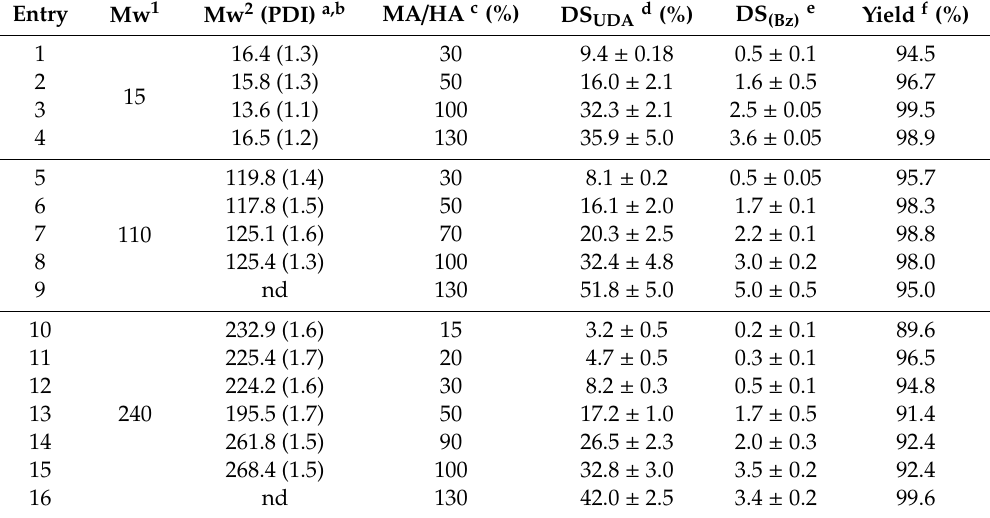
Table 1. Optimization of the esterification reaction for the preparation of Undecenoyl-Hyaluronan (HA-UDA) by varying the molar ratio of mixed